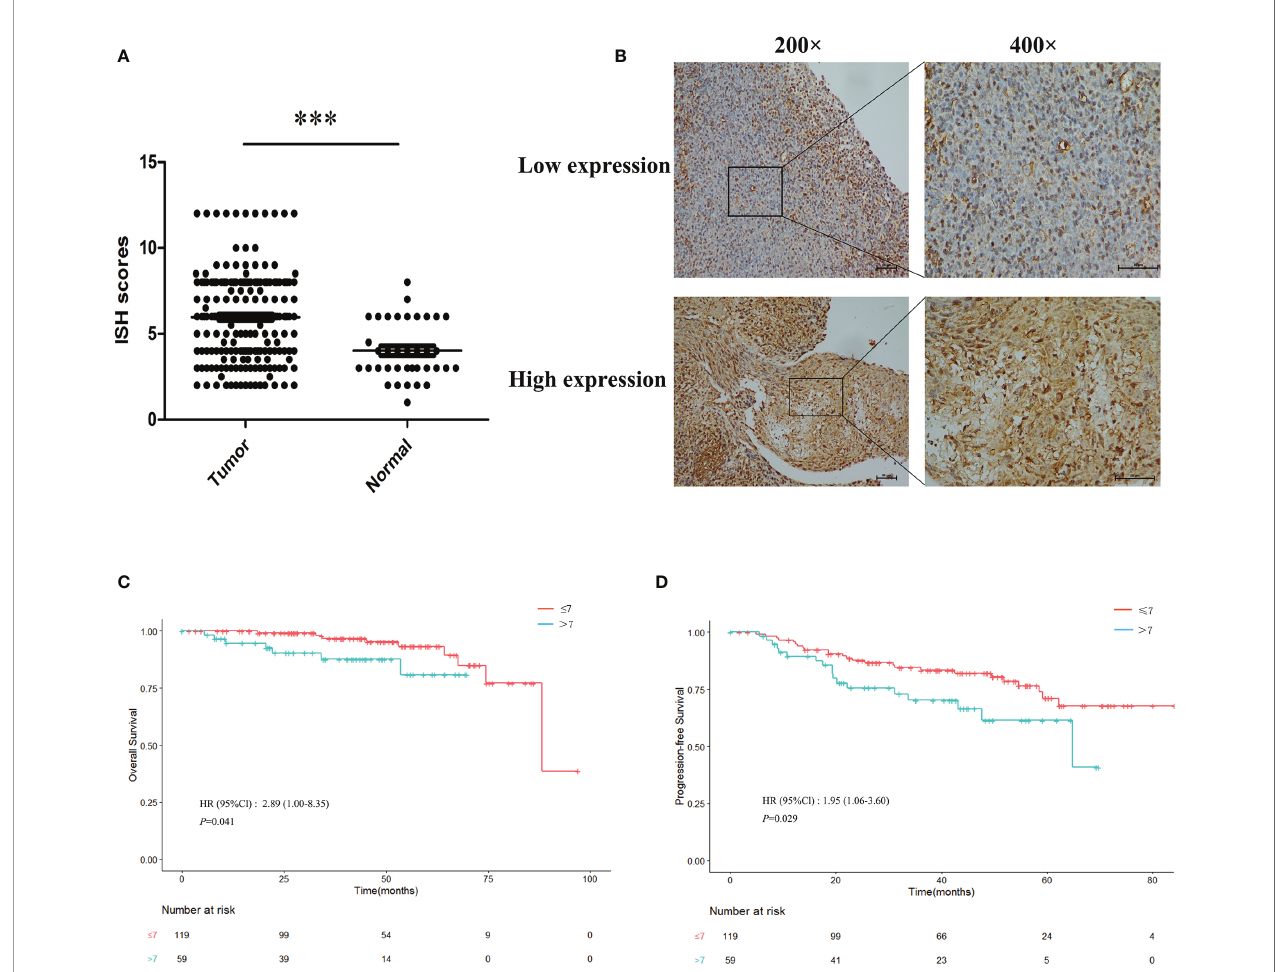
FIGURE 1 | Overexpression of miR-483-5p was associated with poor prognosis in nasopharyngeal carcinoma (NPC) patients. (A) In situ hybridization (ISH) scores in NPC tissues compared with non-tumor tissues. (B) ISH staining of miR-483-5p in representative NPC cases with low and high miR-483-5p expressions (magni fi cation, ×200 and ×400). (C, D) Survival curves for patients with NPC according to the ISH scores. ***P <